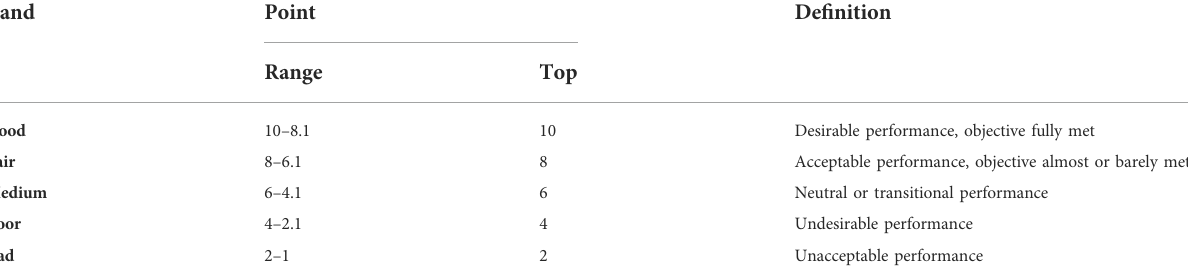
TABLE 2 Five bands of the Barometer of Sustainability proposed by Prescott-Allen (2001), applied for the SSI. Band Point De fi nition Range Top Good 10 – 8.1 8 –